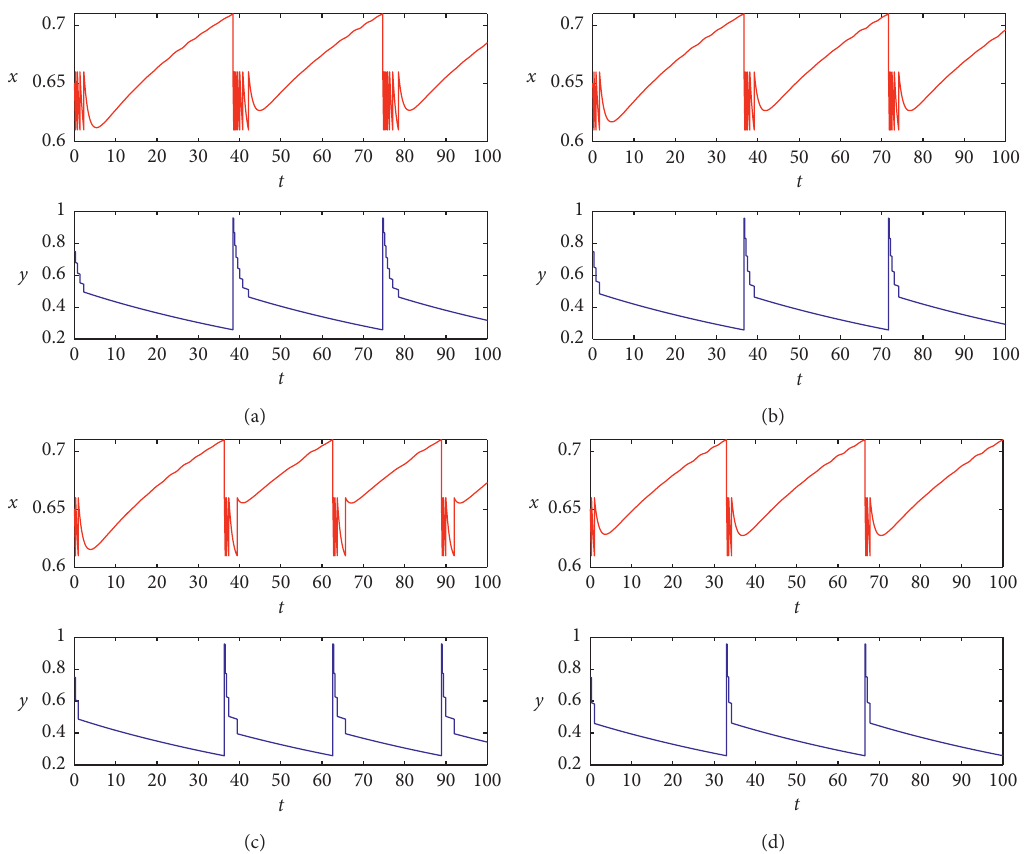
Figure 16: Change of the order of periodic orbits of system (12) for p ∈ [0, 0.3]: (a) order-8 periodic orbit at p � 0.1; (b) order-6 periodic orbit at p � 0.15; (c) order-5 periodic orbit at p � 0.25; (d) order-4 periodic orbit at p � 0.3.